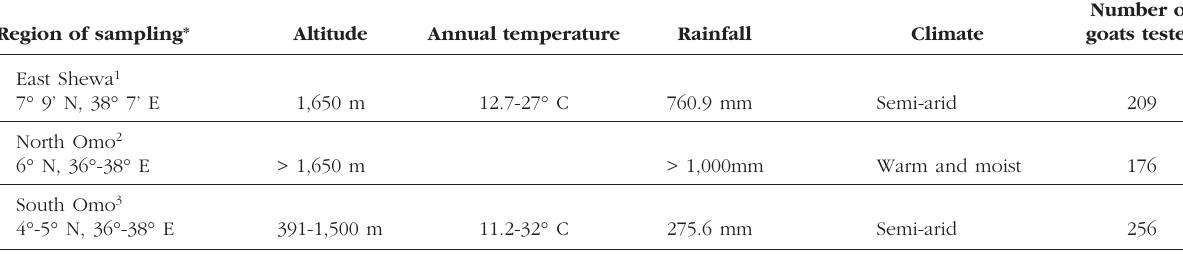
Table I. – Location and climatic conditions of the study areas.